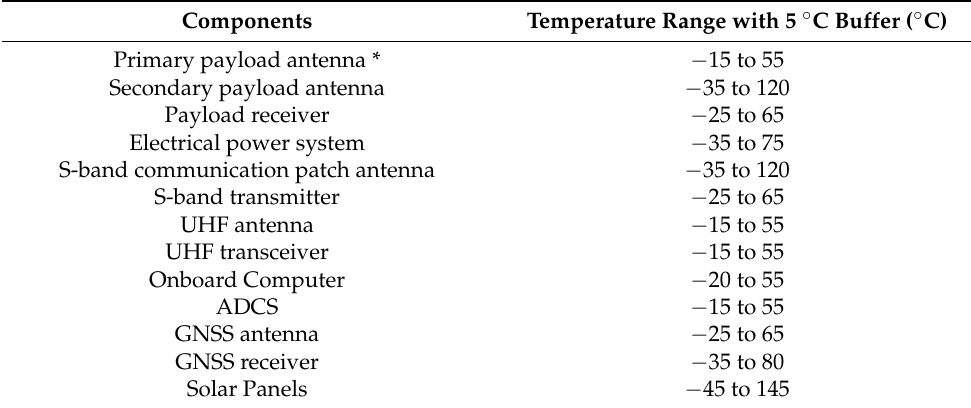
Table 12. Temperature ranges for proposed RMCSat components. * Temperature range of the primary antenna is estimated pending thermal